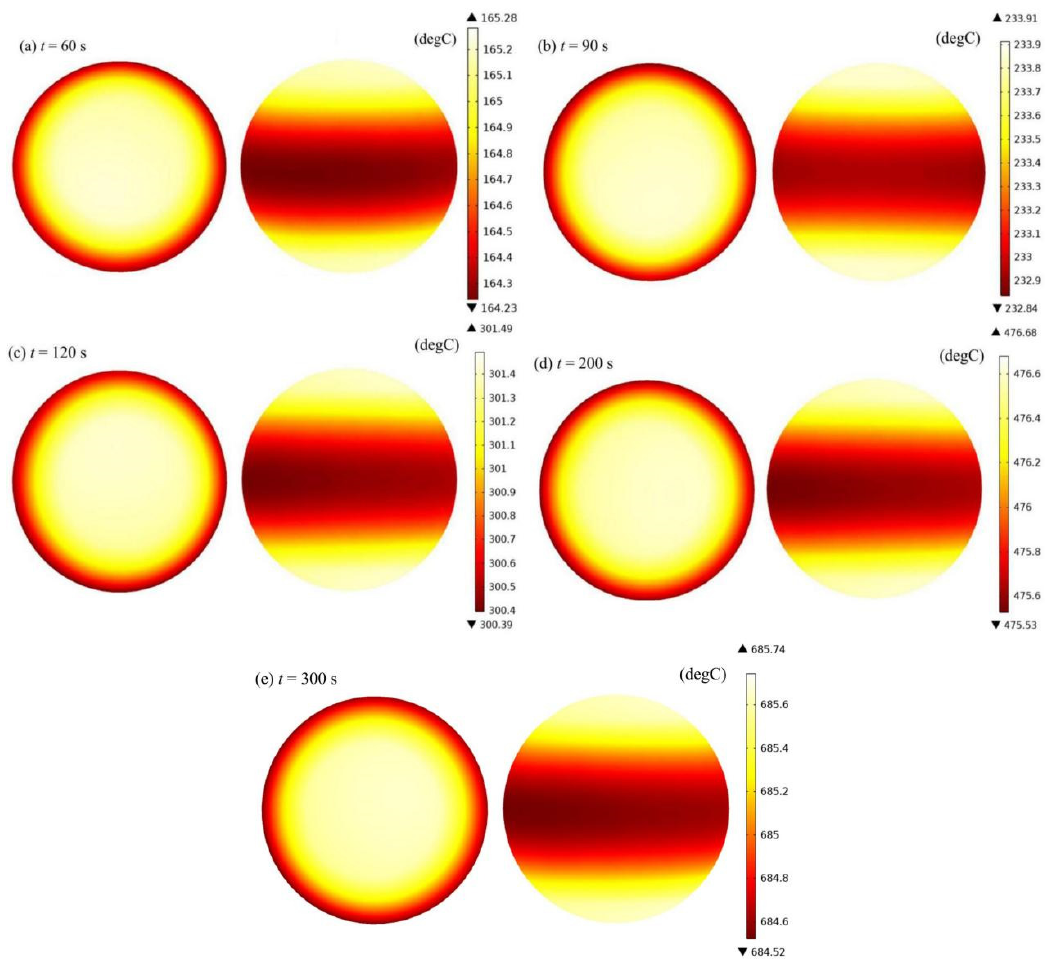
Figure 5. Temperature distribution of oolitic particle model with different microwave heating times and a microwave power of 1000 W: ( a ) 60 s, ( b ) 90 s, ( c ) 120 s, ( d ) 200 s, ( e ) 300 s.